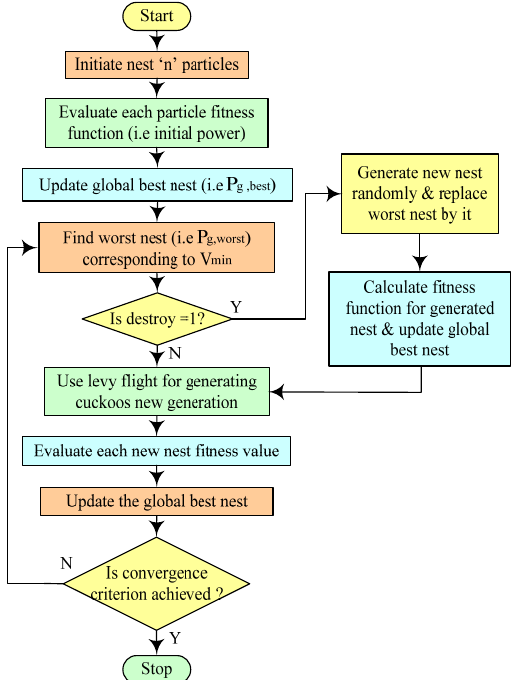
Figure 19. CS-based MPPT technique [87].